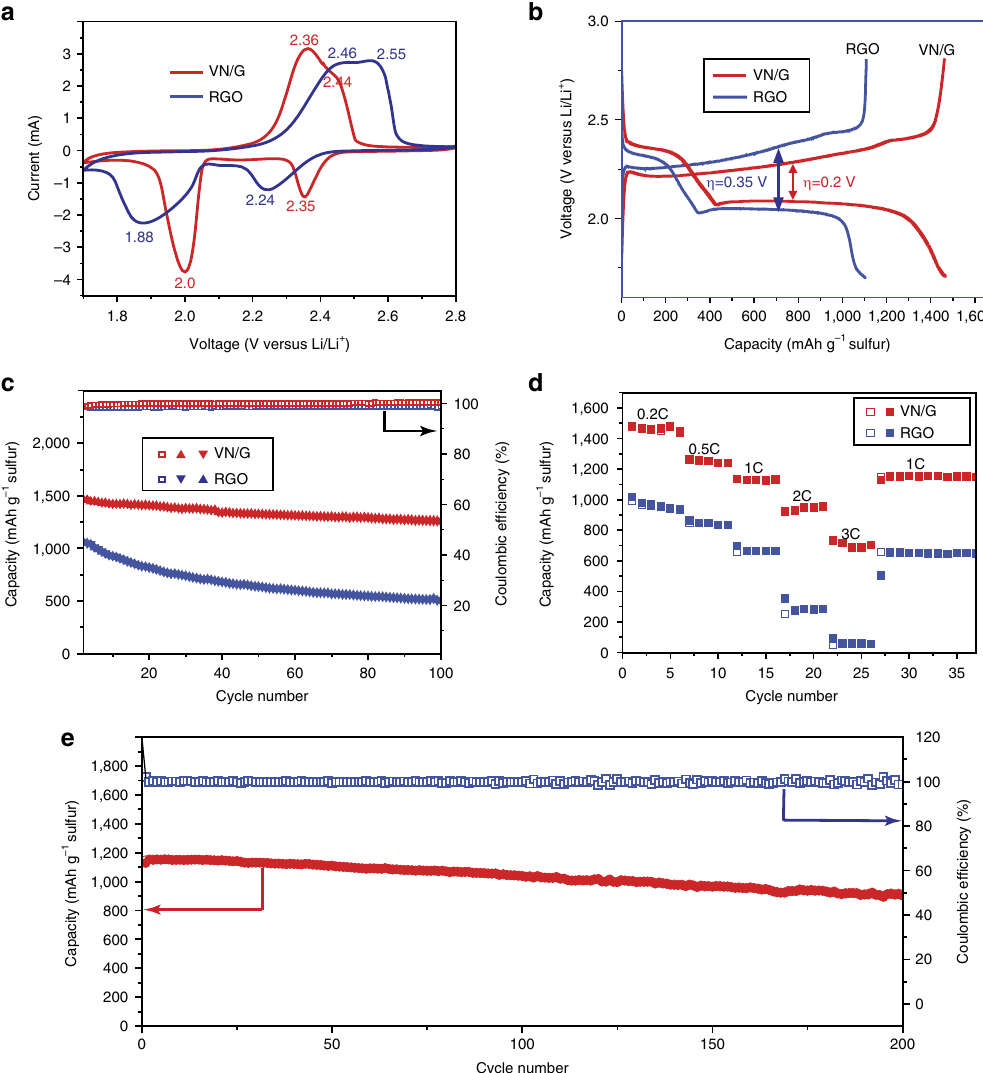
Figure 4 | Electrochemical performances of VN/G and RGO cathodes. ( a ) CV profiles of the VN/G and RGO cathodes at a scan rate of 0.1mVs (cid:2) 1 in a potential window from 1.7 to 2.8V. ( b ) Galvanostatic charge–discharge profiles of the VN/G and RGO cathodes at 0.2C. ( c ) Cycling performance and Coulombic efficiency of the VN/G and RGO cathodes at 0.2C for 100 cycles. ( d ) Rate performance of the VN/G and RGO cathodes at different current densities. ( e ) Cycling stability of the VN/G cathode at 1C for